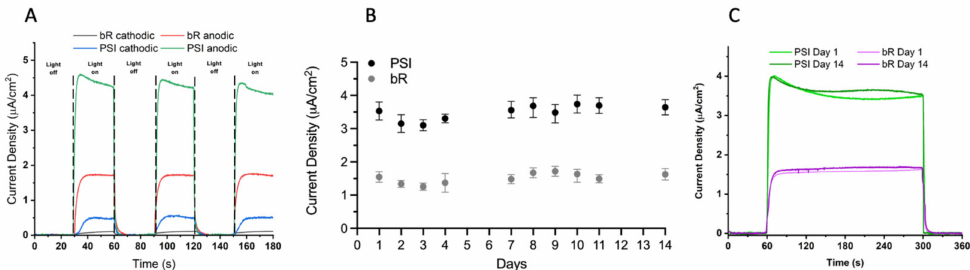
Figure 9. Directional illumination effects on photocurrent density generation and stability of pho- tocurrent response of PSI- and bR-SSCs. ( A ) Comparison of photocurrent densities generated by cathodic or anodic illumination of PSI- or bR-sensitized devices. Traces were baseline corrected using QSOAS software. ( B ) Photocurrent response was measured over two weeks under the same white light illumination regime at 10% light intensity. Each datapoint is the mean photocurrent from three individual traces, and the error bars represent the standard deviation of the mean. ( C ) The average of three individual photocurrent density traces for the PSI-SSC and bR-SSC on days 1 and 14 are